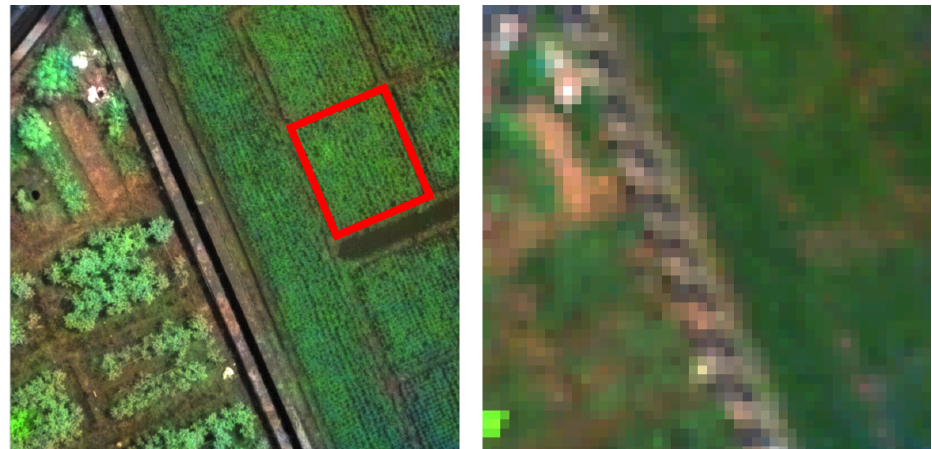
Figure 2. Demonstration of S185 image frame and spatial resolution. Right-hand panel is visualization of S185 at original spatial resolution. Left-hand panel is same view with higher spatial resolution. Red rectangle in left-hand panel is a plot boundary.